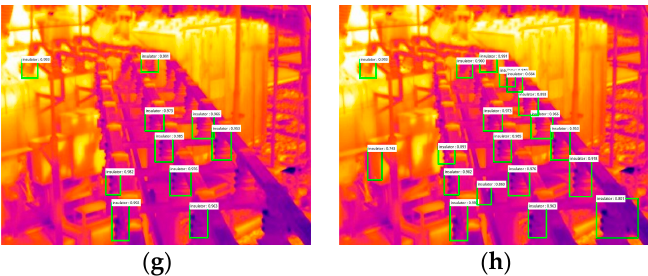
Figure 9. Detection results of insulators with different scales. ( a ),( c ),( e ),( g ) Results obtained by traditional RPN; ( b ),( d ),( f ),( h ) results obtained by improved RPN.